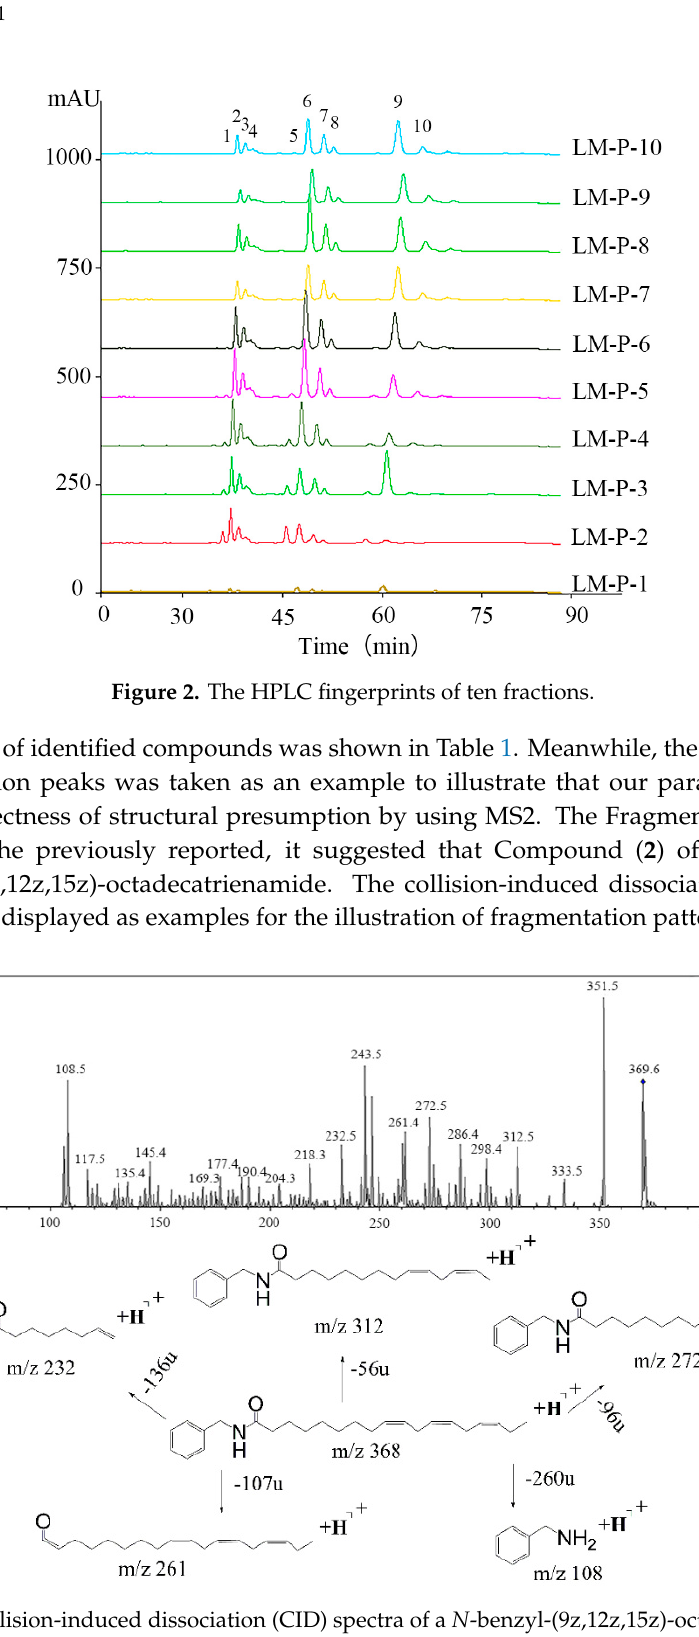
Figure 3. The collision-induced dissociation (CID) spectra of a N -benzyl-(9z,12z,15z)- octadecatrienamide.